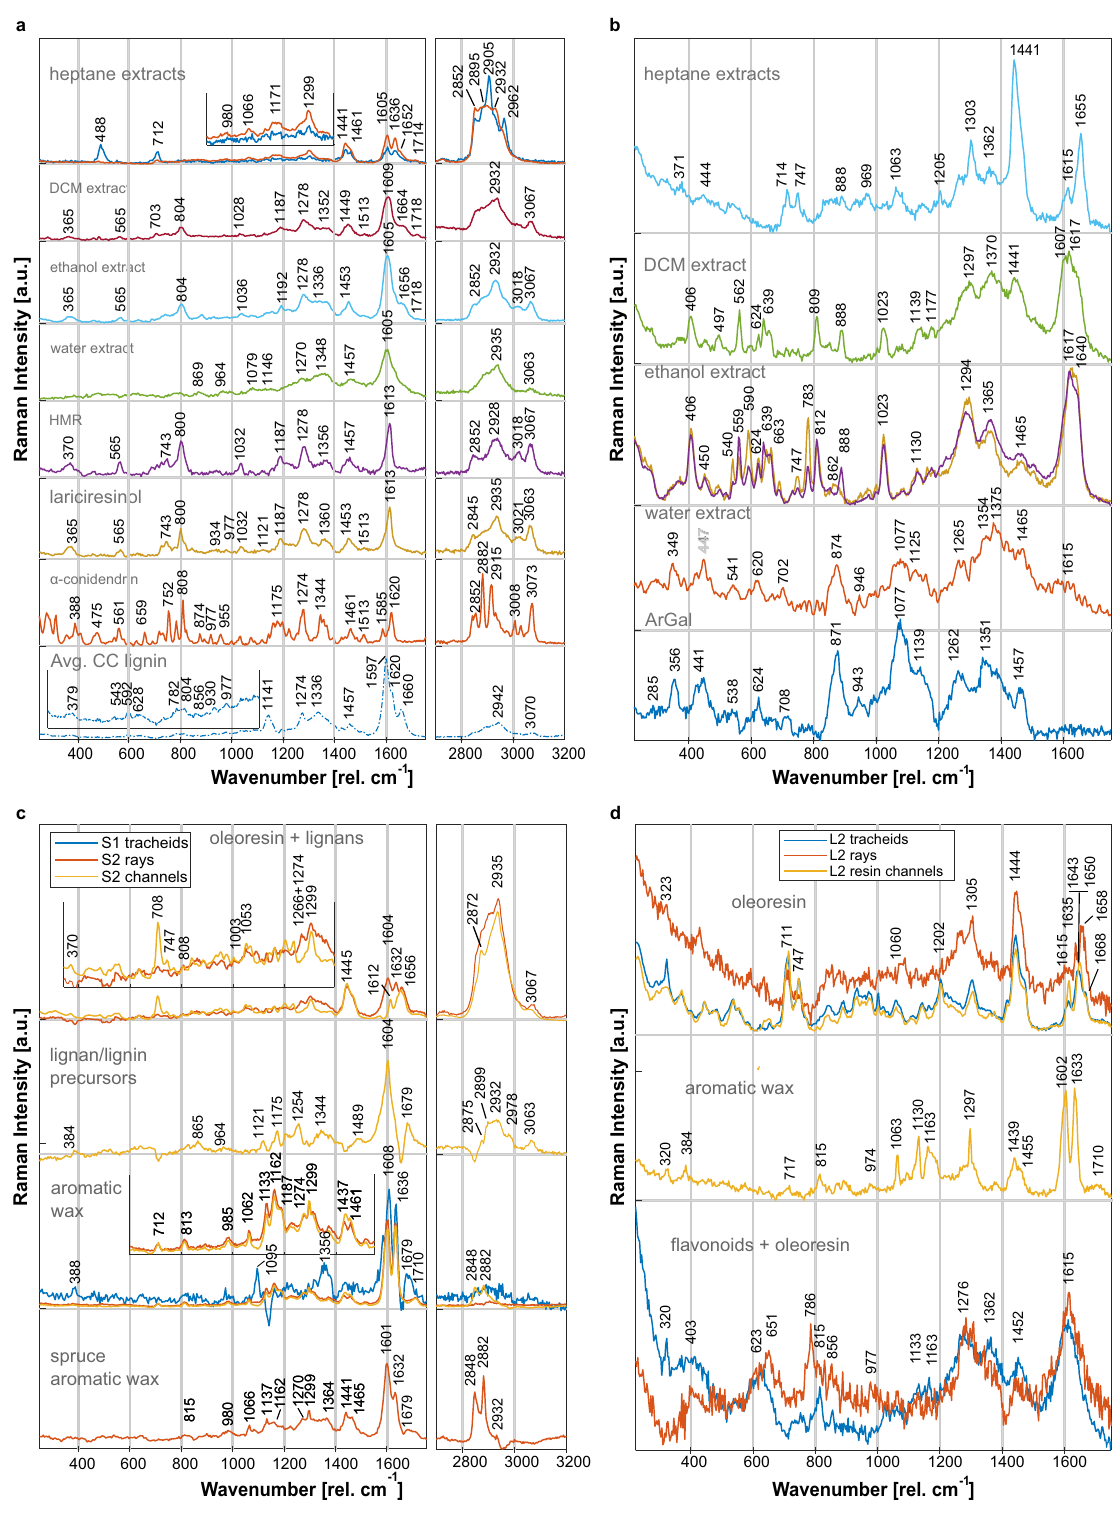
Figure 3. Extractive references and MCR-ALS extractive components of Norway spruce and Kurile larch. Spectra have been normalized for comparison and where relevant, spectra have been zoomed in. ( a ) Spruce references (532 nm excitation): overlay of spectra of heptane extracts of spruce 1 + 2 (blue) and spruce 2 (red); dichloromethane (DCM) extract of spruce 2 after prior heptane extraction; ethanol extract of spruce 2 after heptane and DCM extraction; water extract of spruce 2 after all previous solvents; isolated lignans: hydroxymatairesinol (HMR), lariciresinol and α-conidendrin; average spectrum of spruce cell corner (CC) lignin with zoom on the 250–1100 cm -1 region. ( b ) Larch references (785 nm excitation): heptane extracts, DCM extract, ethanol extract, water extract and pure arabinogalactan (ArGal). ( c ) Spruce MCR-ALS extractive components: Oleoresin with traces of lignans, lignans in the compound middle lamellae (CML), aromatic wax and spruce aromatic wax; ( d ) Larch MCR-ALS extractive component: oleoresin, aromatic wax and flavonoids with traces of